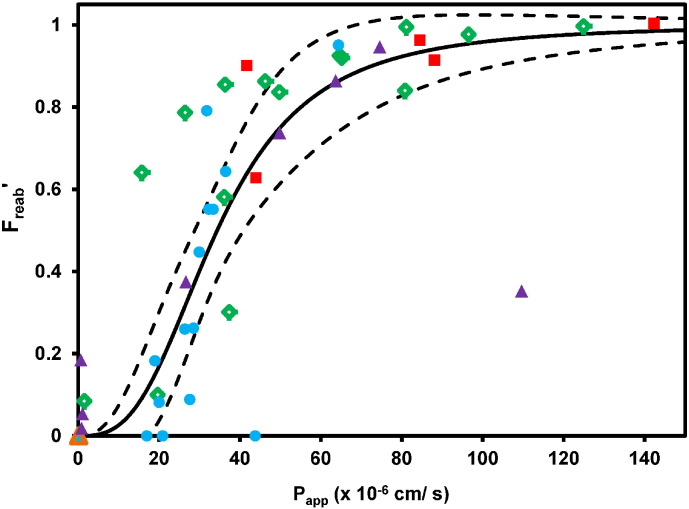
Best-fit curve and 90% confidence interval of the Hill equation to the Papp and Freab′ data for 45 drugs (solid and dashed lines respectively). Symbols indicate neutral (Image 16), basic (Image 17), acidic (Image 18), zwitterion (Image 19) and amphoteric (Image 20) drugs. Drugs with negative values for observed Freab′ are plotted as Freab′ = 0, as described in the text.